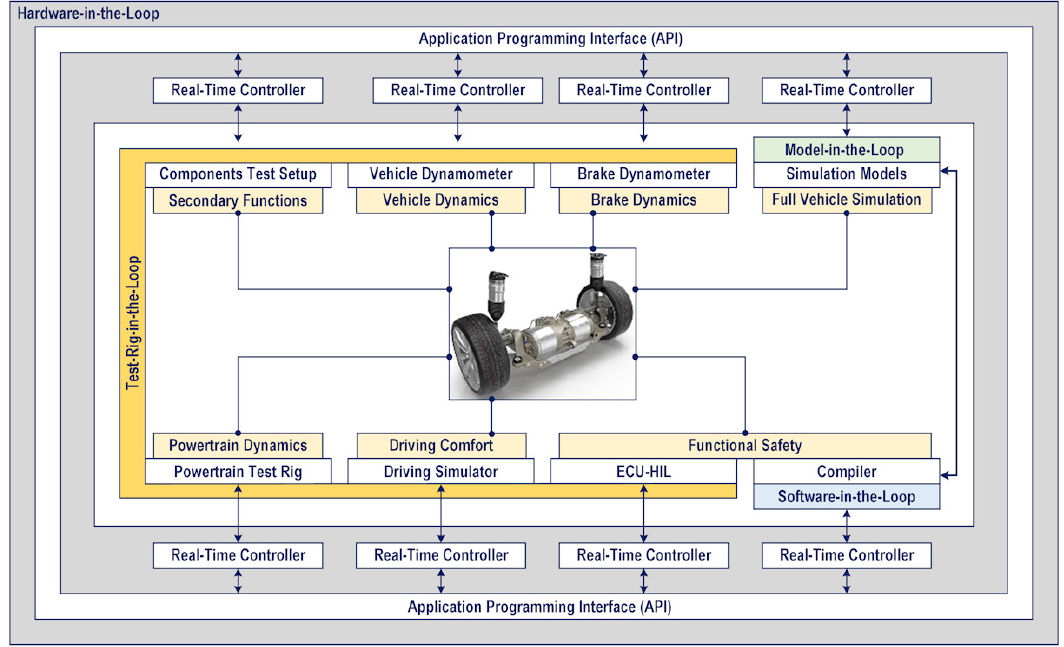
Figure 1. A variant of distributed and shared architecture for electric vehicles (EV) systems